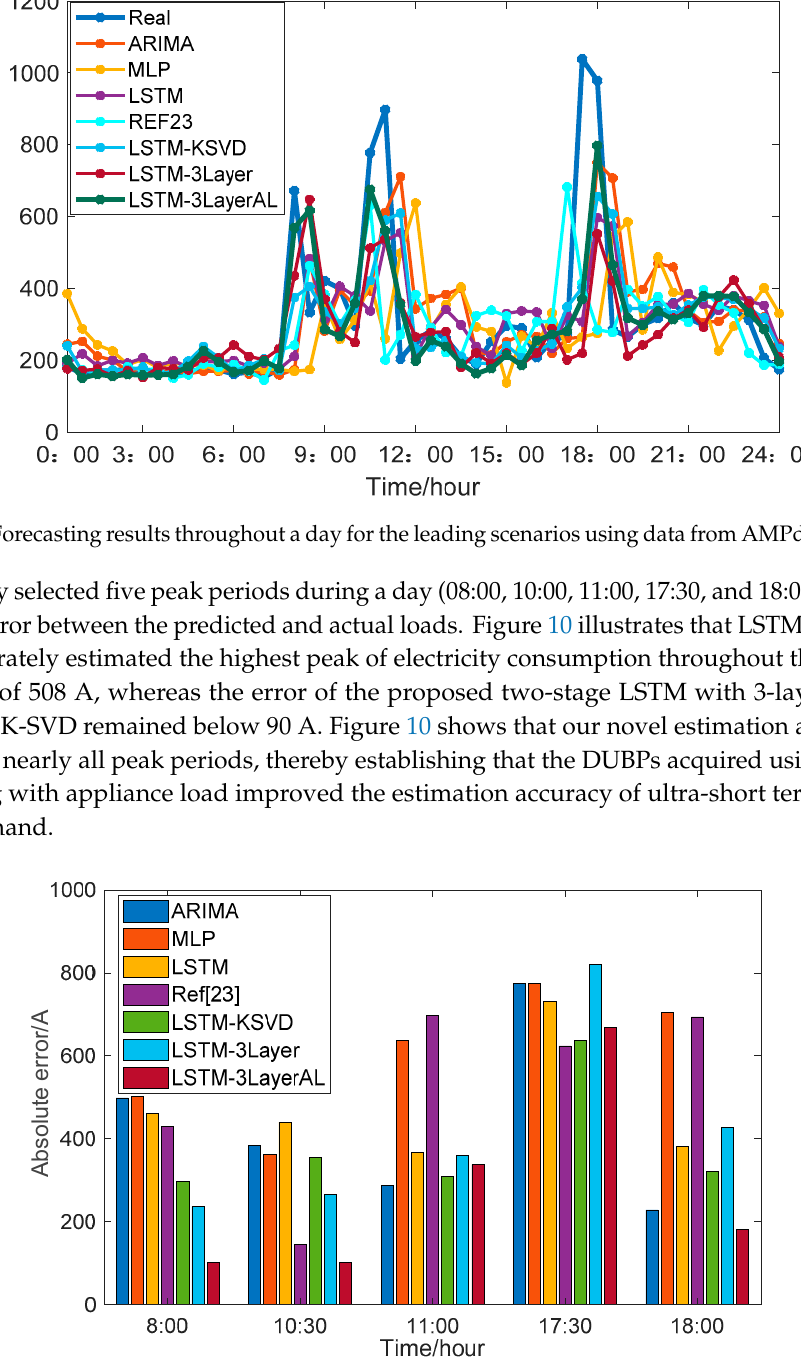
Table 3. Forecasting performance in five houses of REFIT using the proposed method.